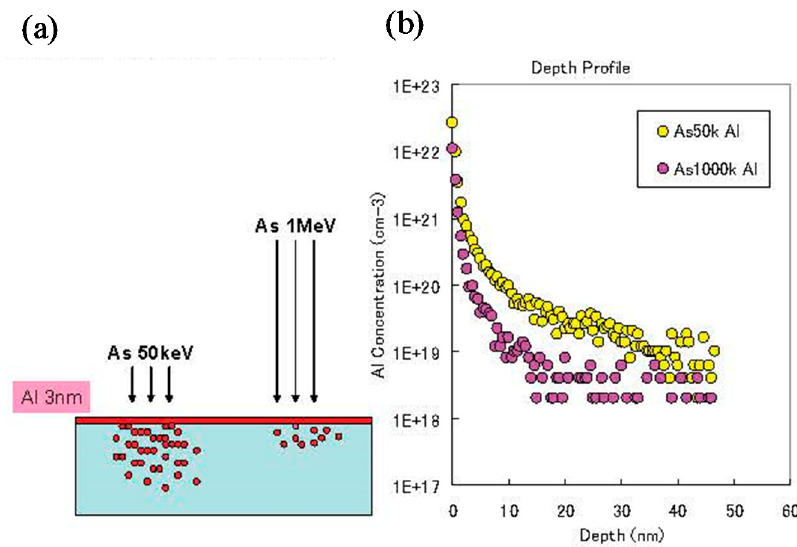
Figure 7. An example of knock-on effect [17]. ( a ) Illustration showing the simulation condition; ( b ) knocked-on aluminum depth profiles by Monte Carlo simulation.